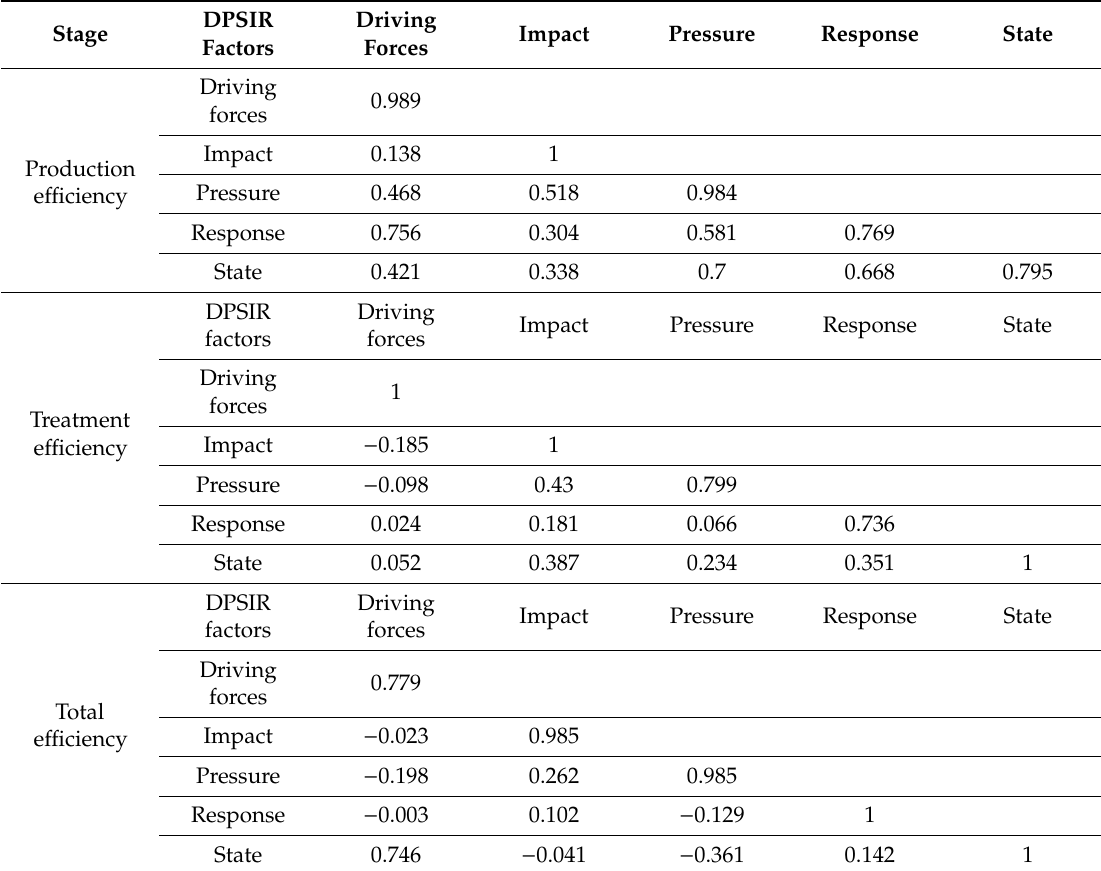
Table 5. Discriminant validity of the DPSIR